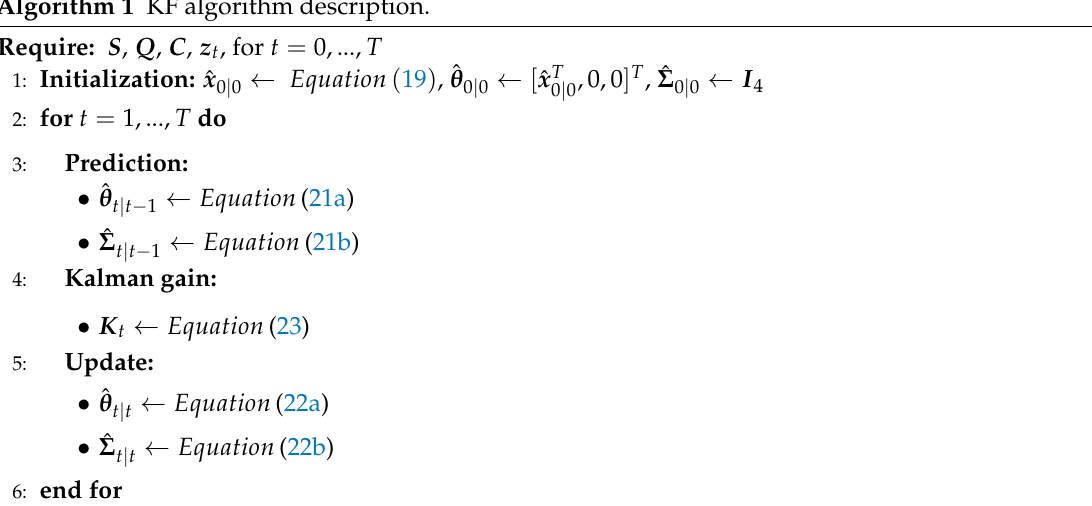
Algorithm 1 KF algorithm